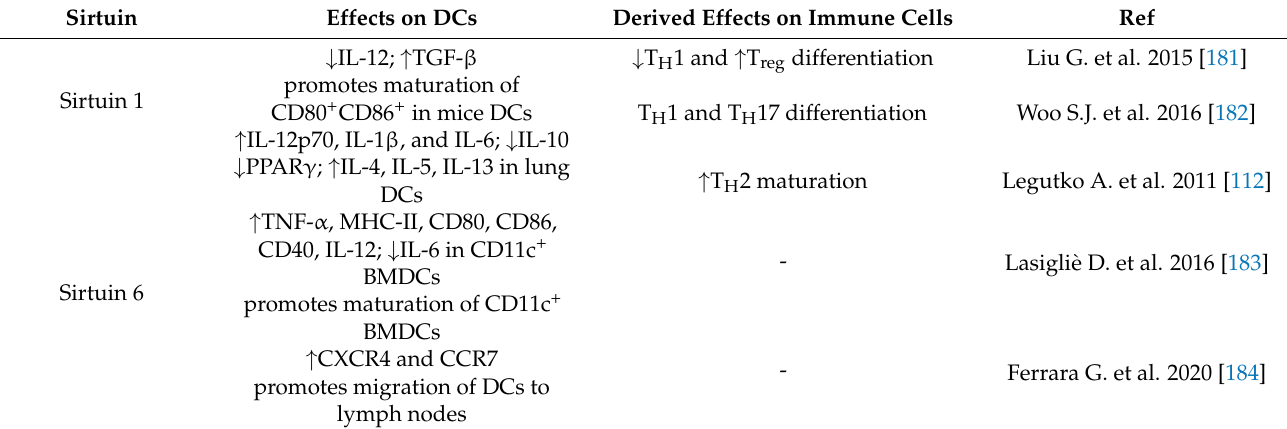
Table 2. Sirtuins effects on dendritic cells and derived effects on immune